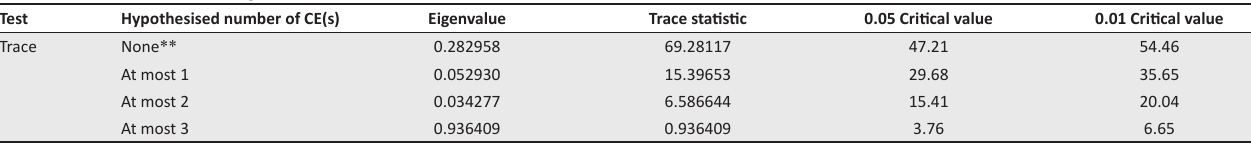
TABLE 3a: Panel Johansen cointegration Trace test results, 1980–2014. Test